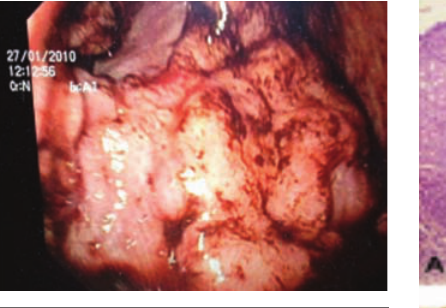
Figure 1. Gastroscopy - tumor presence in the gastric antrum.